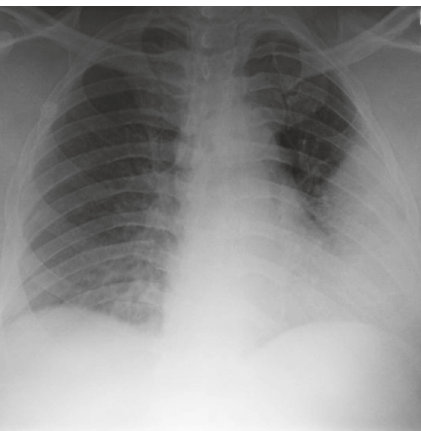
Figure 2: Axial section chest CT showing consolidation in the left lingual with air bronchograms consistent with lobar pneumonia, without pleural effusion.